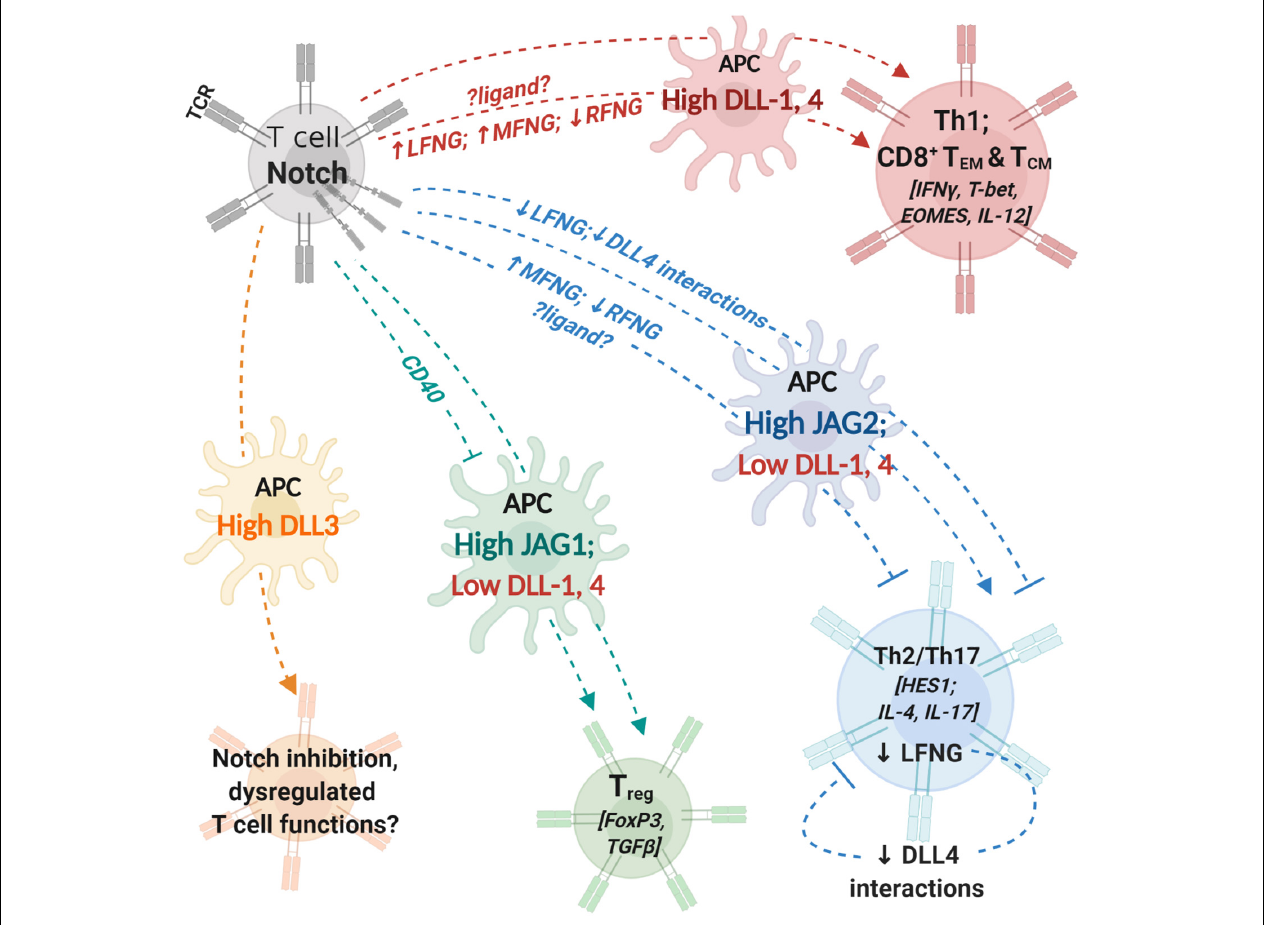
FIGURE 1 | Notch interactions between antigen-presenting cells and T cells influence helper and effector T cell activity. T cells express T cell receptor (TCR) complex and Notch receptors. Antigen-presenting cells (APCs) express costimulatory molecules and Notch ligands. During T cell activation, the identity of Notch ligand present on the cell surface of APCs can influence T cell polarization and differentiation. Changes in expression levels of fringe glycosyl transferases can influence the process by modifying Notch receptor affinity to different ligands. Notch signaling in T cells regulates expression of transcription factors and cytokines (indicated within []) involved in helper and cytotoxic T cell functions. APCs with high expression levels of DLL1 or DLL4 can polarize CD4 + T cells into aTh1 phenotype and drive CD8 + T cell differentiation into memory cells. Increase ( ↑ ) in LFNG and MFNG expression and downregulation/loss ( ↓ ) of RFNG expression can enhance Th1 differentiation; identity of ligands involved in fringe-mediated Th1 differentiation are yet to be investigated (represented by ?ligand?). APCs with high JAG2 and low DLL1,4 expression drive helper T cell differentiation into Th2 or Th17 phenotypes. Expression of MFNG and downregulation of RFNG can block Th2 differentiation. Loss of LFNG in uncommitted T cells as well as Th2 polarized cells inhibits Notch interactions with DLL4 and attenuates Th2 responses. APCs with high JAG1 expression can induce T cell polarization into regulatory T cells (T reg ). CD40 blockade together with JAG1 expression on APCs enhances immunosuppressive functions of T reg cells. APC, antigen presenting cell; DLL, Delta-like ligand; JAG, Jagged ligand; LFNG, lunatic fringe; MFNG, manic fringe; MHC, major-histocompatibility complex; TCR,; Th1, T helper type 1, Th2: T helper type 2; Th17, T helper type 17; T reg , T regulatory cell; T EM , effector-memory T cell; T CM , central-memory T cell; RFNG, radical